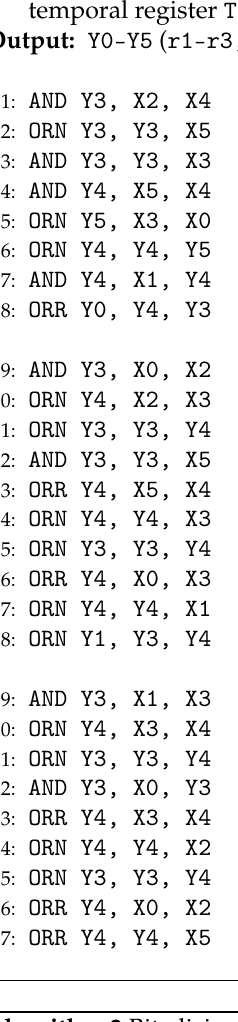
Algorithm 2 Bit-slicing implementations of ShiftColumns.